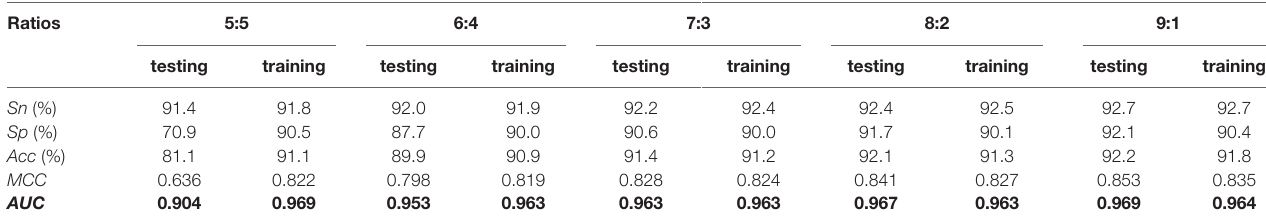
TABLE 3 | Predictive performances of five ratios on the testing and training datasets.